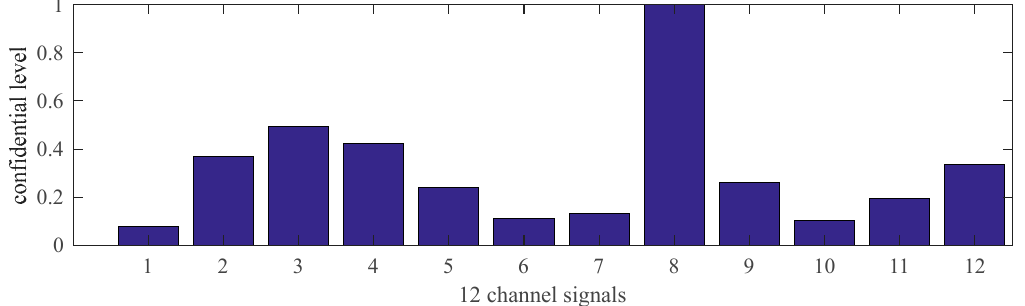
Figure 13. The confidence levels of 12 channel signals based on Algorithm 3.